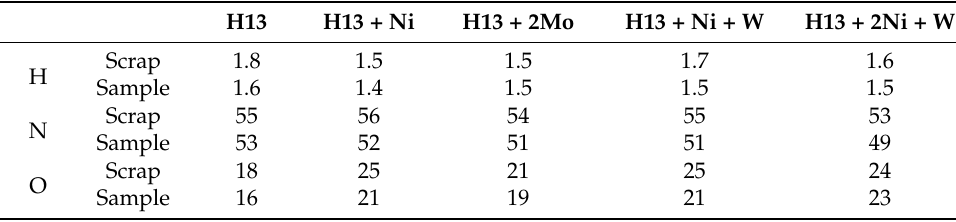
Table 6. H, N, and O contents of steel scrap and the samples